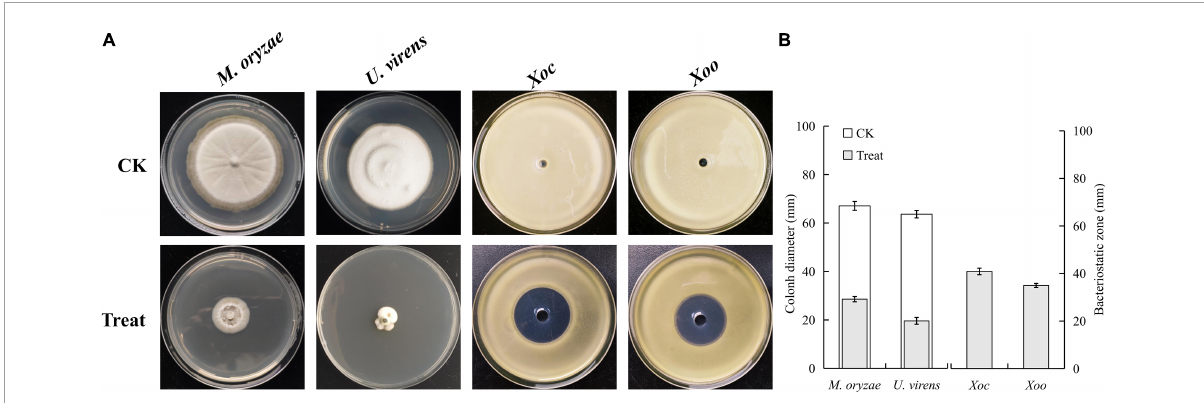
FIGURE7 (A) Antibacterial activity test of B. velezensis BR-01 culture extract and (B) data statistics. Fungal plate photographs were taken when pathogenic fungi in the control group grew to about 3/4 of the culture dish. Bacterial plate photographs were taken after 2 days of culture. All plates were placed at 28 ◦